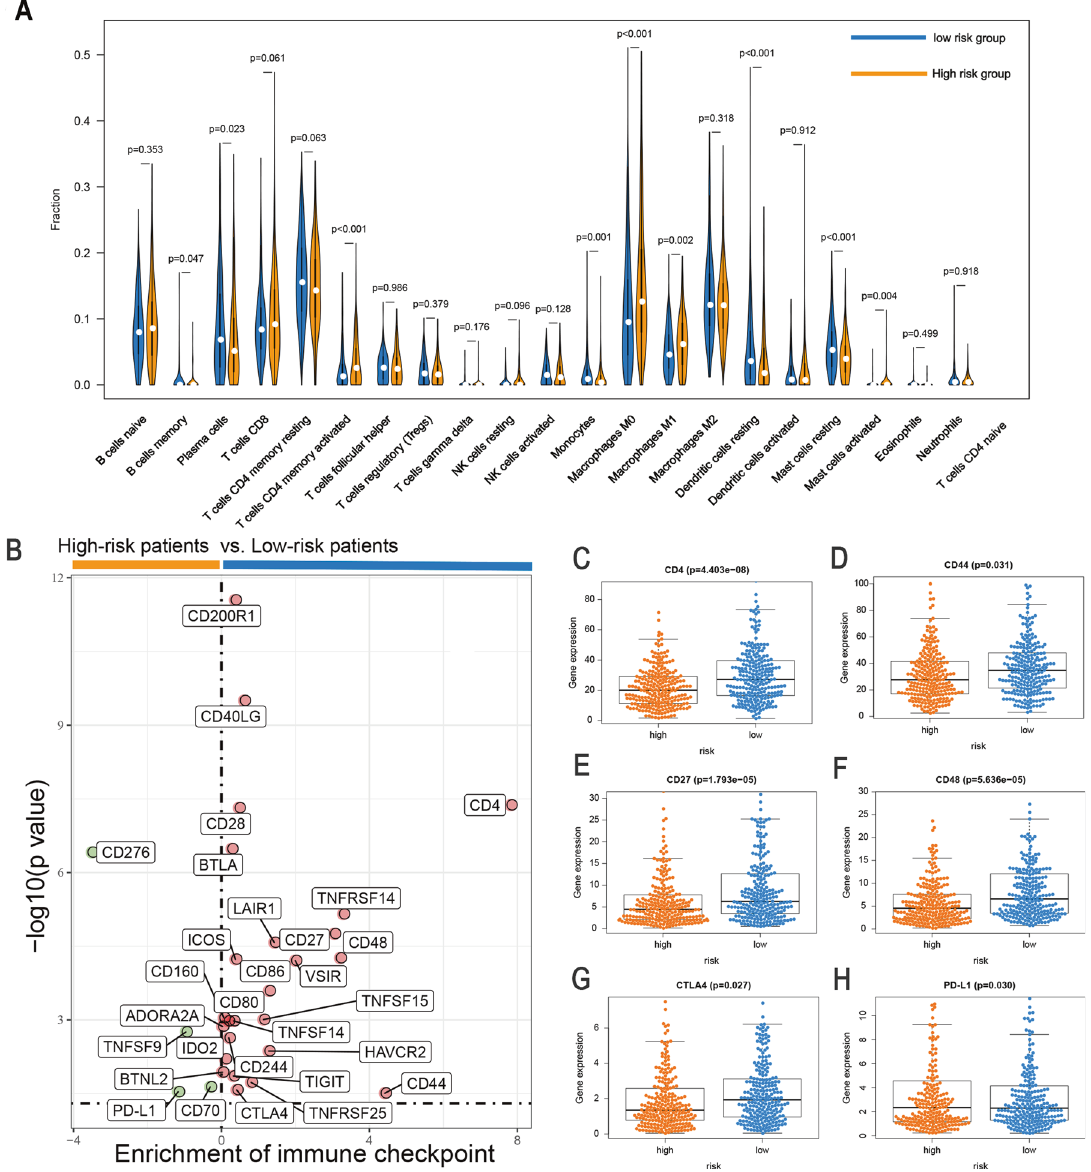
Fig. 8 Comparison of the immune microenvironment and immune checkpoints with LUAD between the high-risk and low-risk groups. A Violin plot of immune-in fi ltrating lymphocytes between the low-risk and high-risk groups, in which orange indicates high-risk samples and blue indicates low-risk samples. B Volcano plots for the enrichment of expression of immune checkpoints between the low-risk and high-risk groups. The differential expression of six immune checkpoints, ( C ) CD4, ( D ) CD44, ( E ) CD27, ( F ) CD48, ( G ) CTLA4, and ( H ) PD-L1, between the high-risk group and the low-risk group. Orange indicates high-risk patients, and blue indicates low-risk